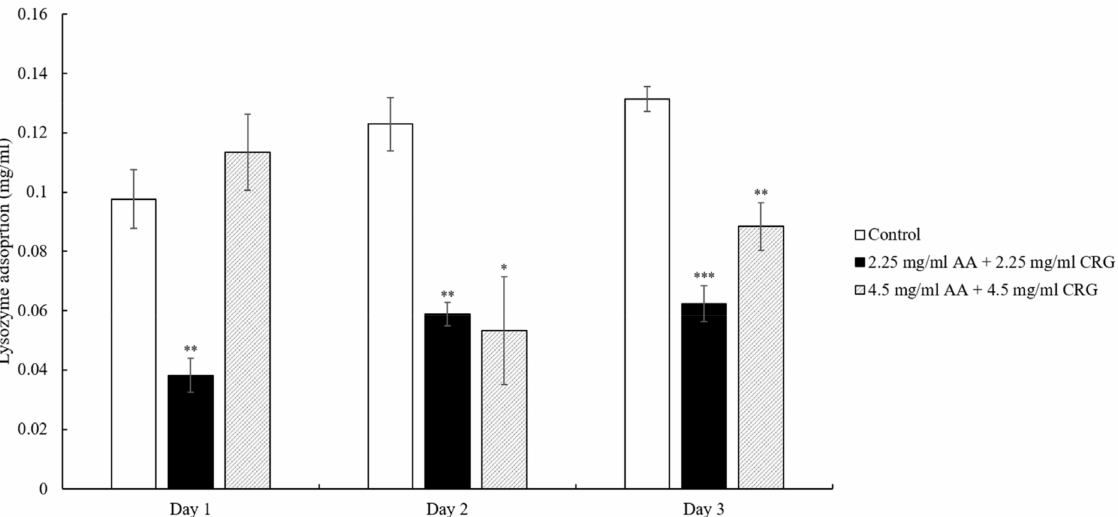
Figure 4. The concentration of lysozyme adsorption on the ortho-k lens when being immersed in artificial tear solution (control, white bars), 2.25 mg/mL (black bars) or 4.5 mg/mL (grey slashed bars) polysaccharides-containing artificial tear solution. * p < 0.05, ** p < 0.01, and *** p < 0.001 when comparing lysozyme adsorption amount in polysaccharides-containing artificial tear solution versus in control on the same day. Error bars represented standard